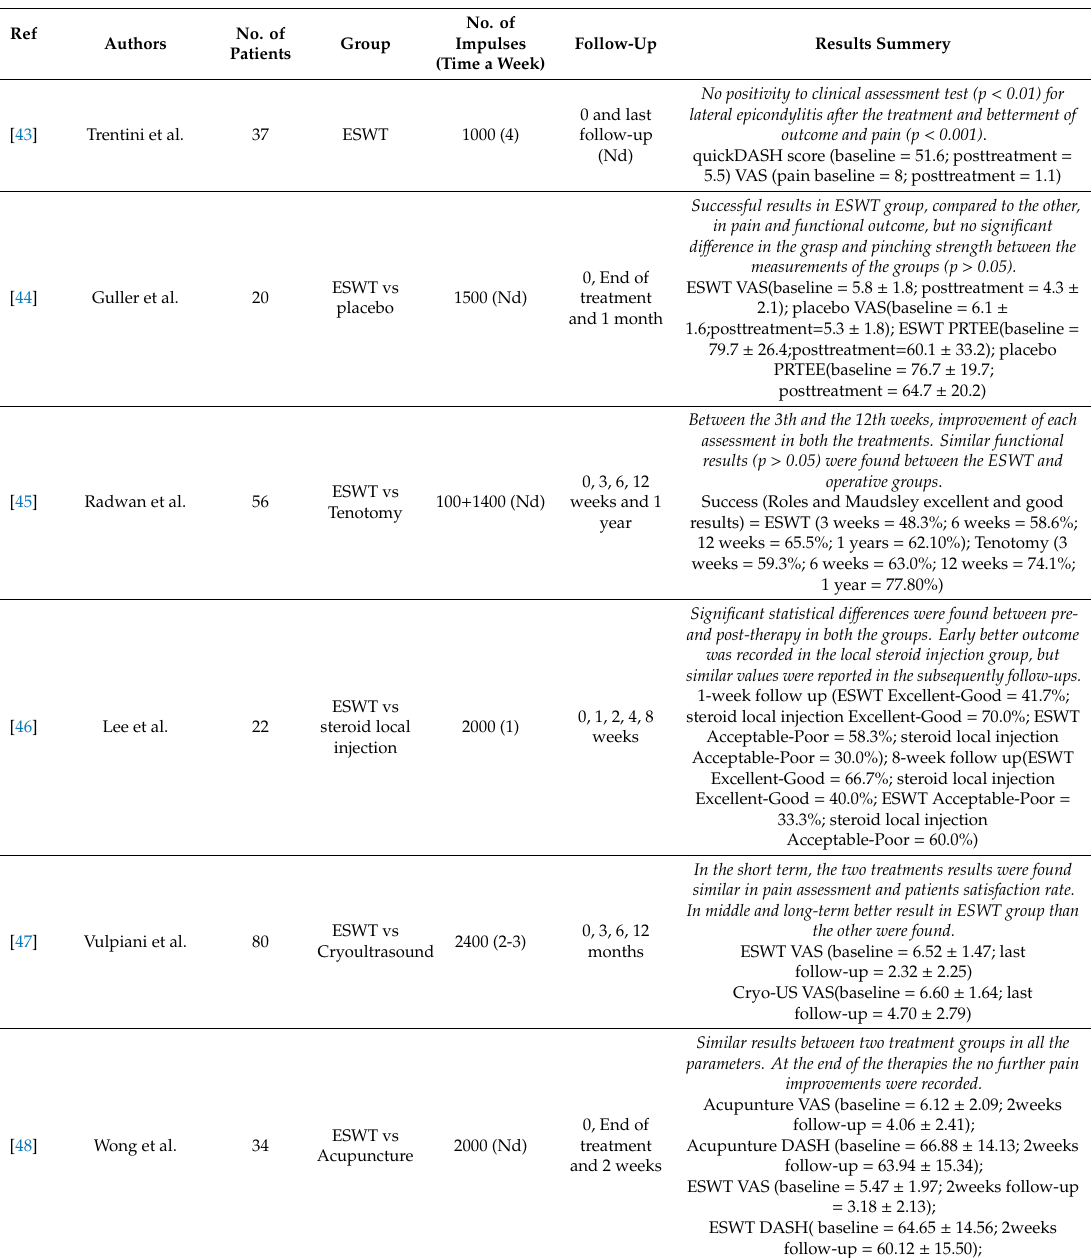
No positivity to clinical assessment test (p < 0.01) for lateral epicondylitis after the treatment and betterment of 0 and last outcome and pain (p < 0.001) . follow-up quickDASH score (baseline = 51.6; posttreatment = (Nd) 5.5) VAS (pain baseline = 8; posttreatment = 1.1) Successful results in ESWT group, compared to the other, in pain and functional outcome, but no significant di ff erence in the grasp and pinching strength between the measurements of the groups (p > 0.05). and 1 month